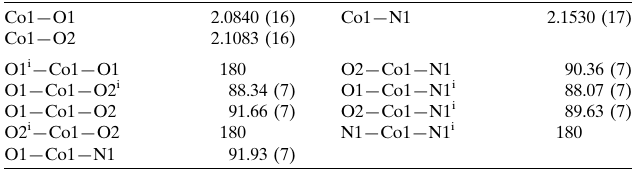
Selected geometric parameters (A˚ , (cid:3) ).